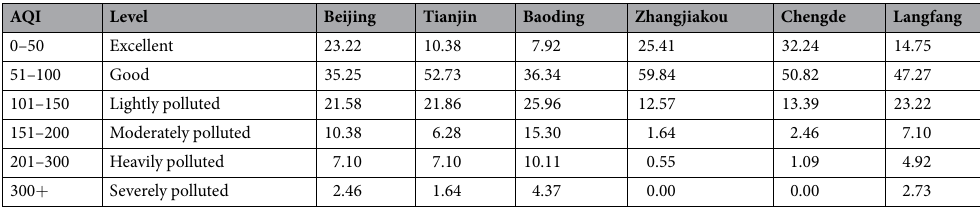
Table 2. Air pollution level by city (Unit: